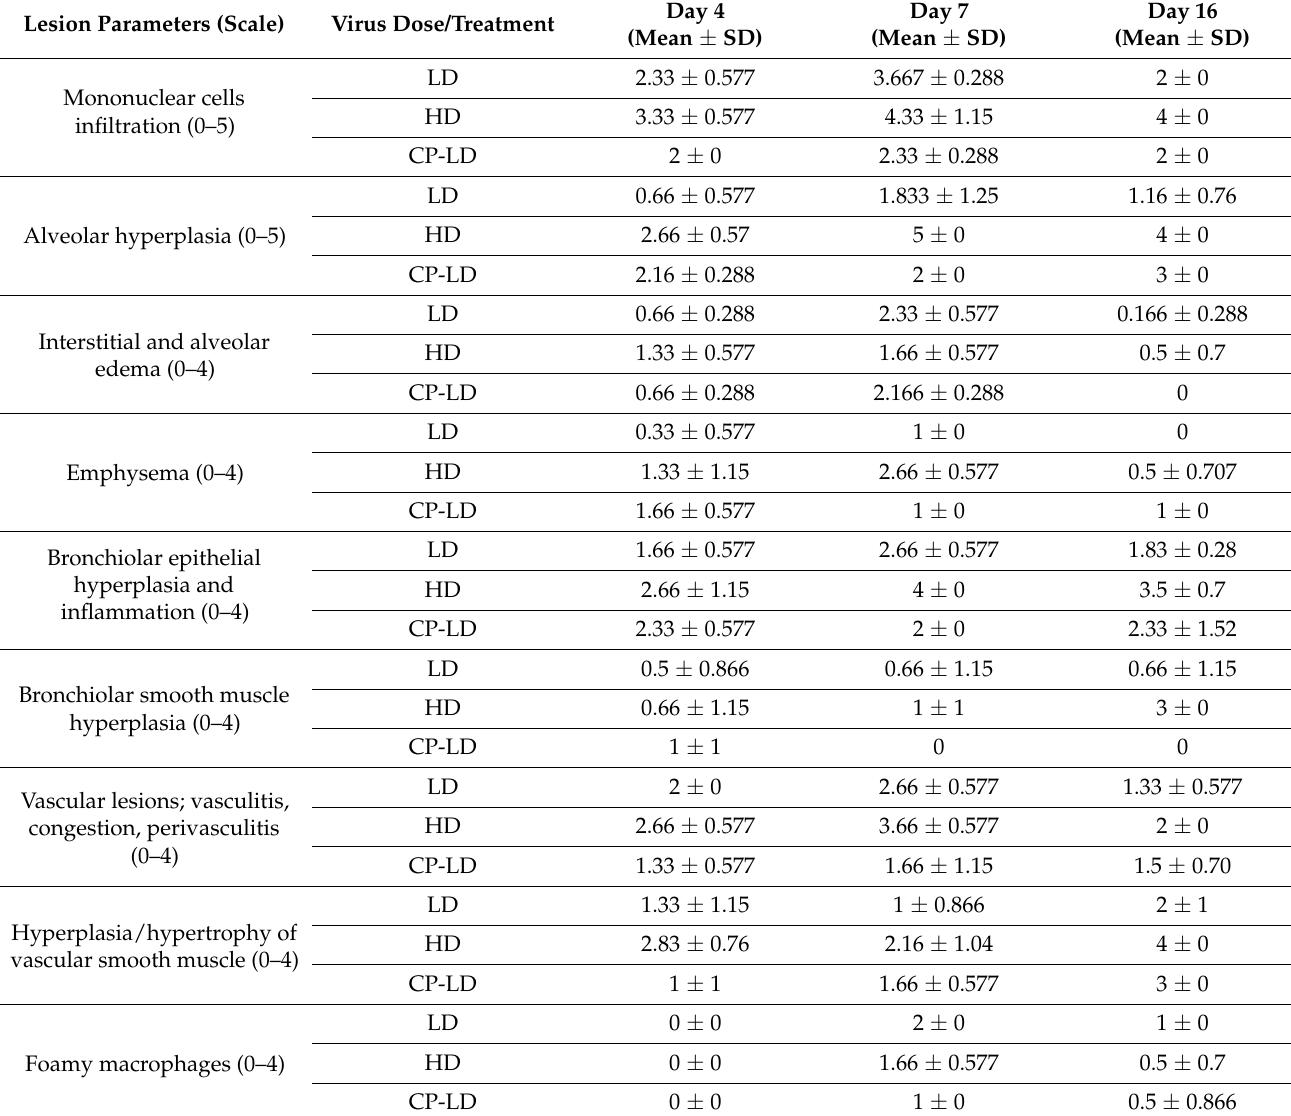
Table 2. Histopathological scoring of SARS-CoV-2-infected hamster